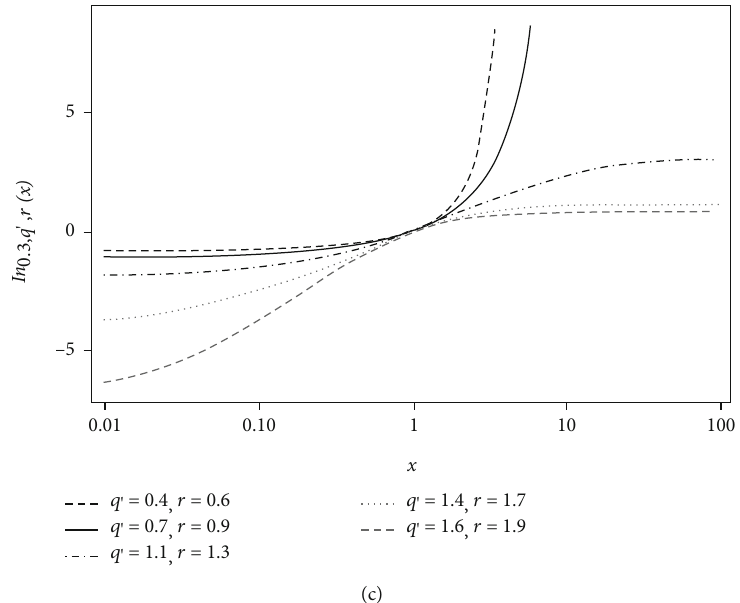
Figure 2: (a) Illustration of the three-parameter logarithm for fi xed value of r . (b) Illustration of the three-parameter logarithm for fi xed value of q ′ . (c) Illustration of the three-parameter logarithm for fi xed value of q